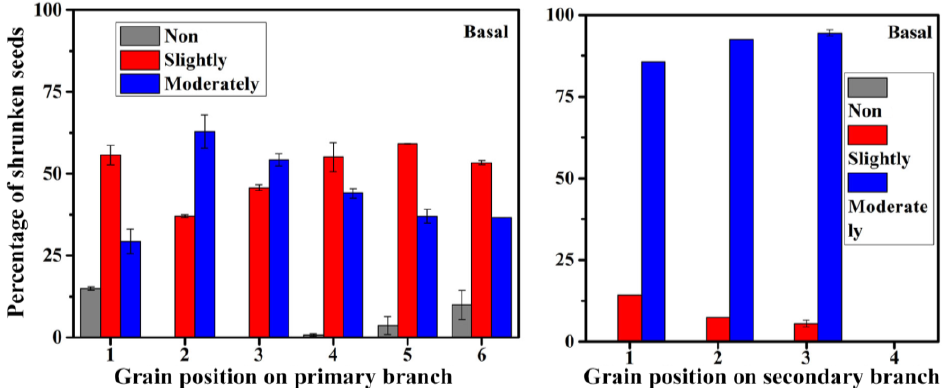
Figure 7. Distributions of differently shrunken seeds on rice panicle. The number of the grain position on the panicle is shown in Figure 1. Data are means ± SD from three biological replicates.